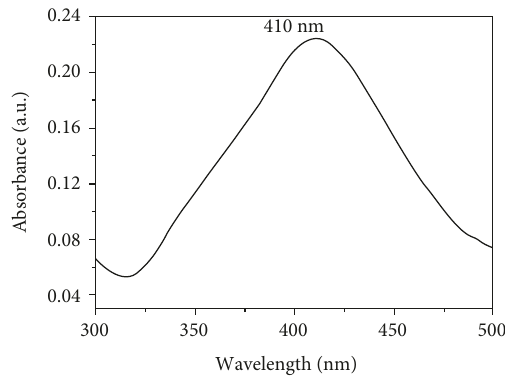
Figure 1: UV-Vis spectrum of